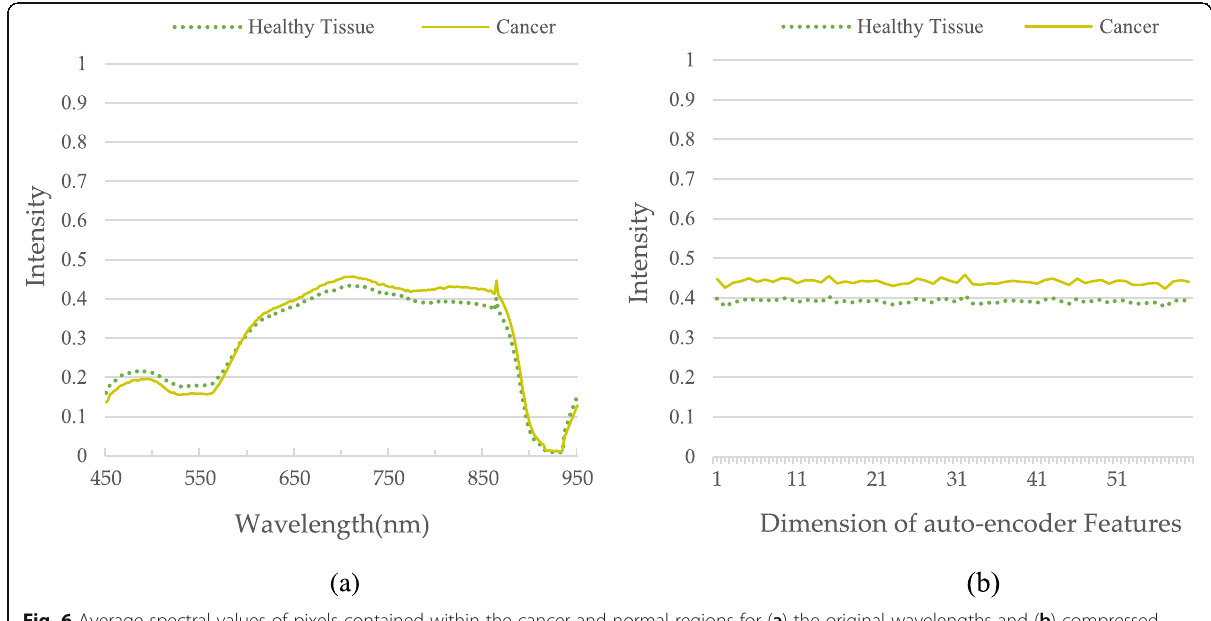
Fig. 6 Average spectral values of pixels contained within the cancer and normal regions for ( a ) the original wavelengths and ( b ) compressed features gotten by